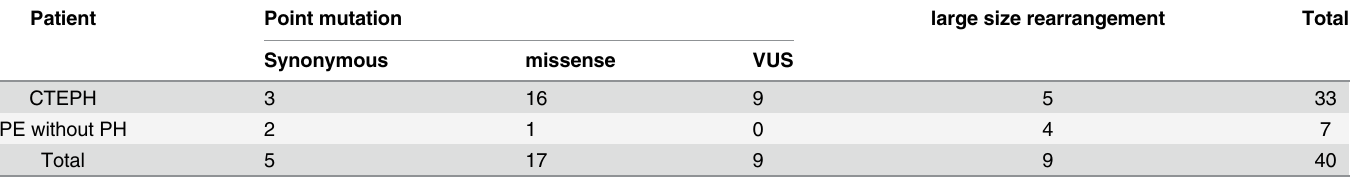
Table 3. categories of gene mutations in CTEPH patients and PE without PH patients.